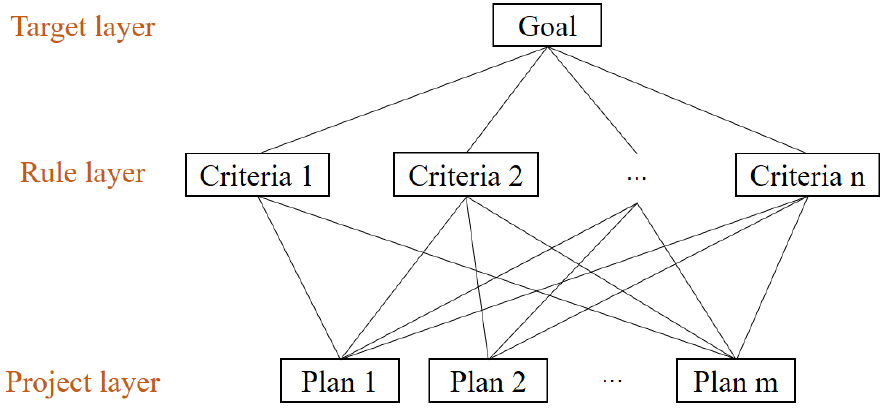
Figure 2. AHP method.